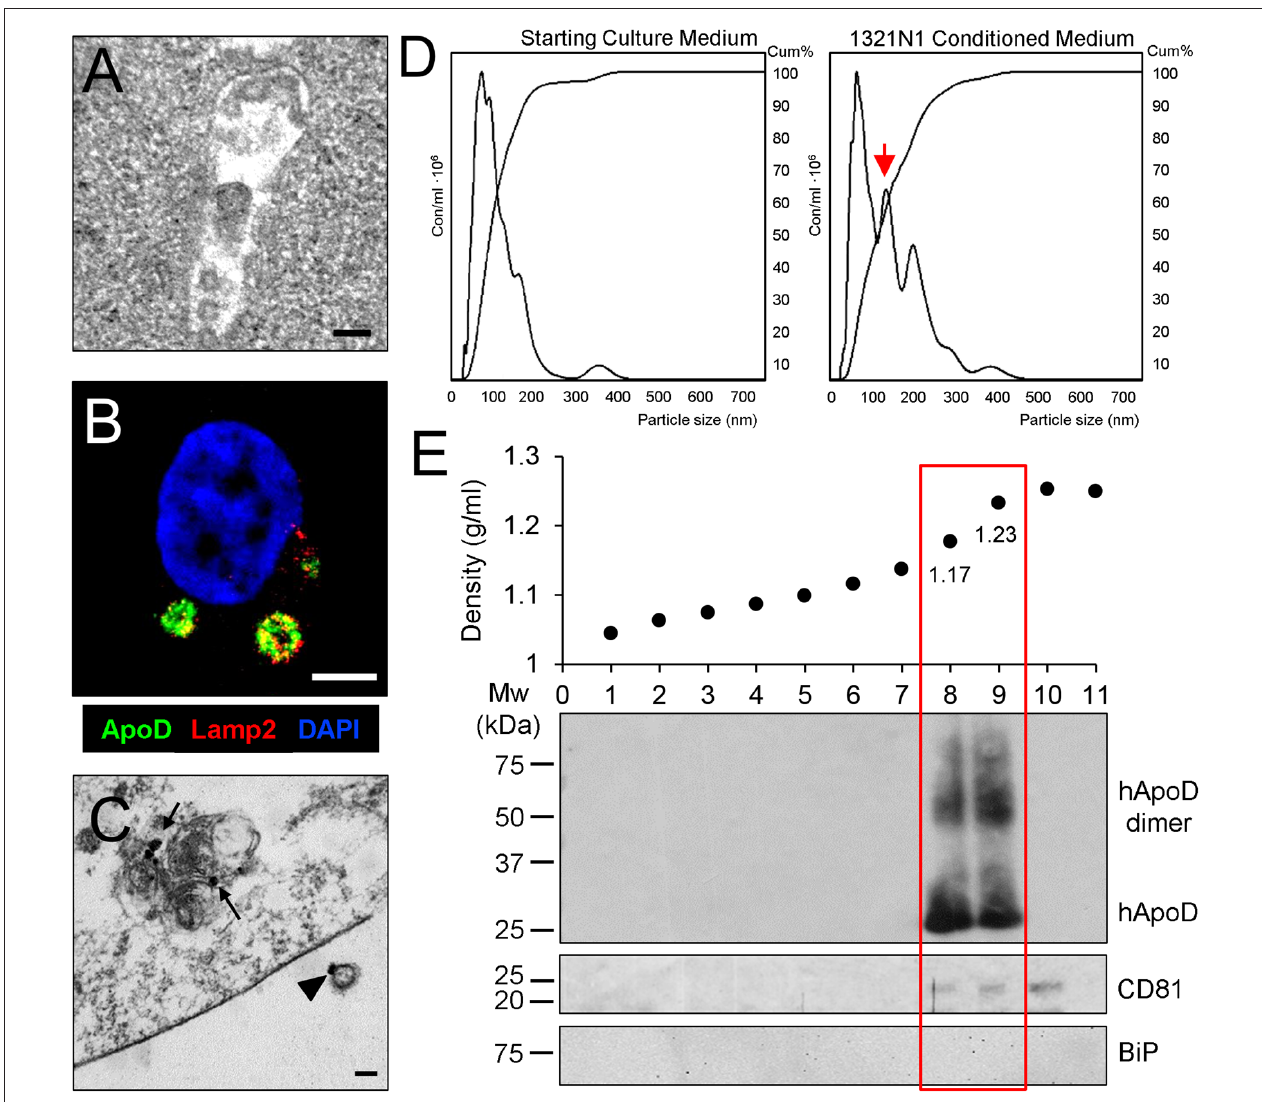
FIGURE 4 | ApoD is specifically found in EV fractions containing astrocyte-derived exosomes. (A) Electron microscopy image of a multivesicular body (MVB) in the cytoplasm of a 1321N1 astrocyte. (B) Single plane confocal microscopy image extracted from a Z-stack of a 1321N1 astrocyte showing the colocalization of ApoD and Lamp2 in putative MVBs. (C) Immunoelectron microscopy image showing ApoD in mature lysosomes of a 1321N1 cell (arrows), and on the external surface of a putative exosome (arrowhead). Calibration bars: (A,C) : 100 nm; (B) : 5 µ m. (D) Nanoparticle tracking analysis (NTA) of the starting culture medium or 1321N1-CM shows that 1321N1 astrocytes secrete several EV populations with a group showing particle size compatible with exosomes (red arrow). EV preparations were obtained from two pools of two independent cell culture sets (480 × 10 6 cells/preparation). Particle size: 92 and 97 nm, respectively. Particle concentration: 218 × 10 9 and 222 × 10 9 particles/ml respectively. (E) Fractionation of EV preparation from 1321N1 astrocytes by sucrose gradient. The plot shows the fraction density along with the immunoblot analysis of each fraction with ApoD, CD8 and BiP antibodies. Only fractions 8 and 9 are positive for ApoD, while the exosome marker CD81 appears in fractions